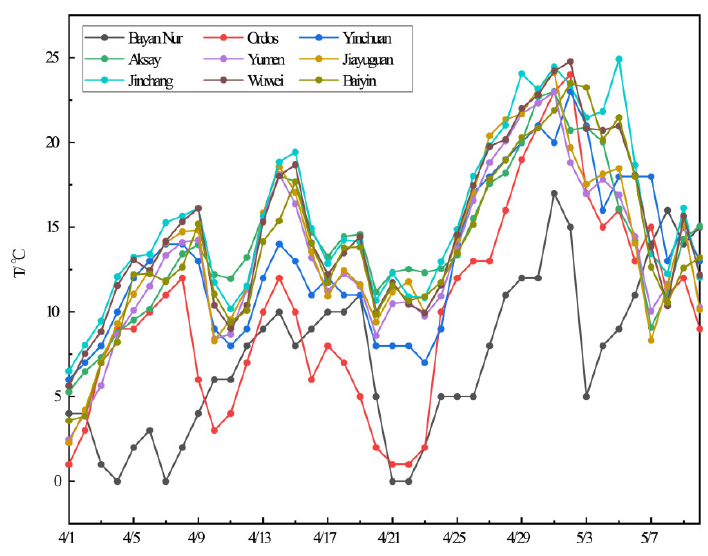
Figure 5. The average daily temperature of cities examined from 1 April to 10 May 2020.